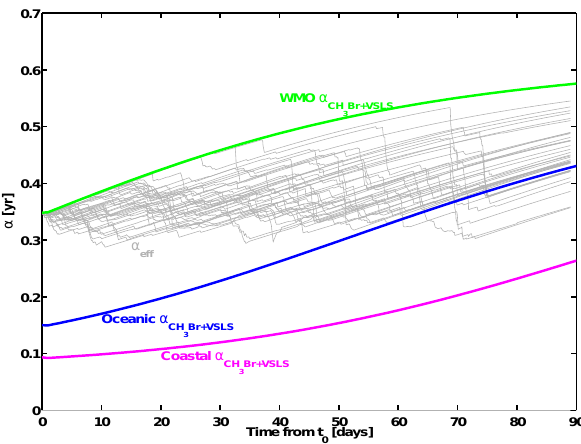
Fig. 5. The cumulative lifetime ( α ) in years of the short-lived bromine substances for the WMO upper troposphere (green), oceanic (blue) and coastal (magenta) regions from the concentra- tion curves displayed in Fig. 2. Displayed in light grey is 50 exam- ple trajectories with their respective cumulative lifetimes – showing how convection from different source regions changes the α values (as the VSLS composition